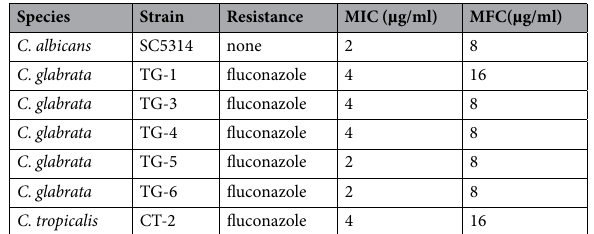
Table 1. Activity of C4 against disseminated candidiasis clinical isolates.